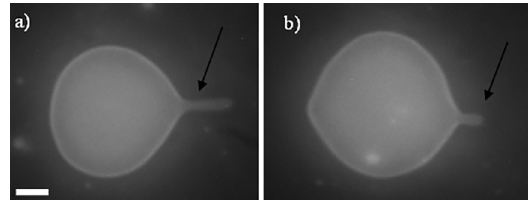
Figure 3. Sequence of optical fluorescence microscopy images of GUVs comprised of DLPC and 0.5 % of rhodamine: (a) immediately after the addition of 3 drops of concentrated glucose and (b) natural return of the filament to the vesicle. Bar = 5 µm.